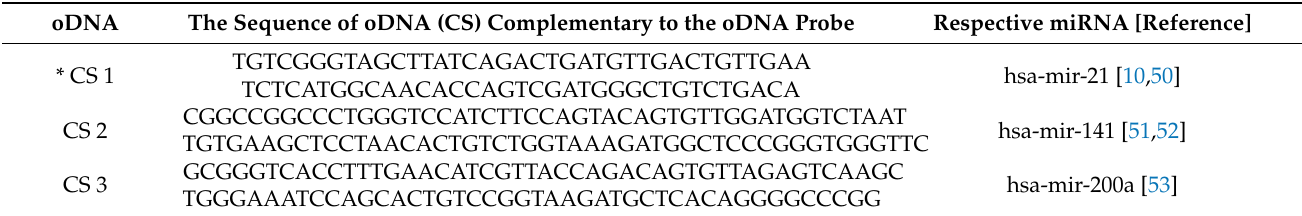
Table 3. Nucleotide sequences of oDNA targets and miRNAs corresponding to them. oDNA